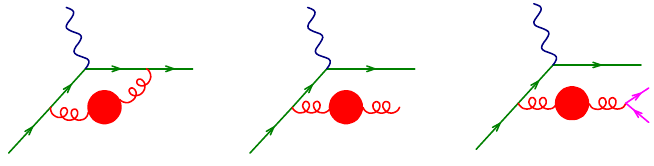
Figure 5 . Representative graphs for the calculation of F 2 in the large n f